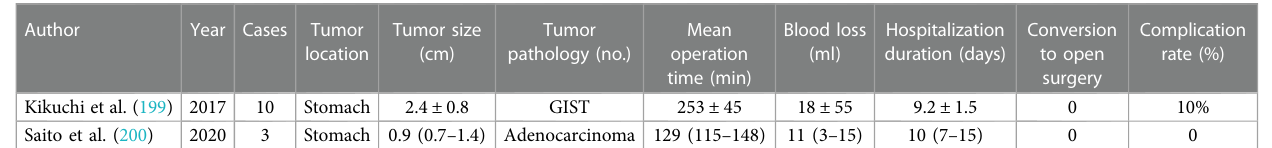
TABLE 16 Research studies of the closed-LECS